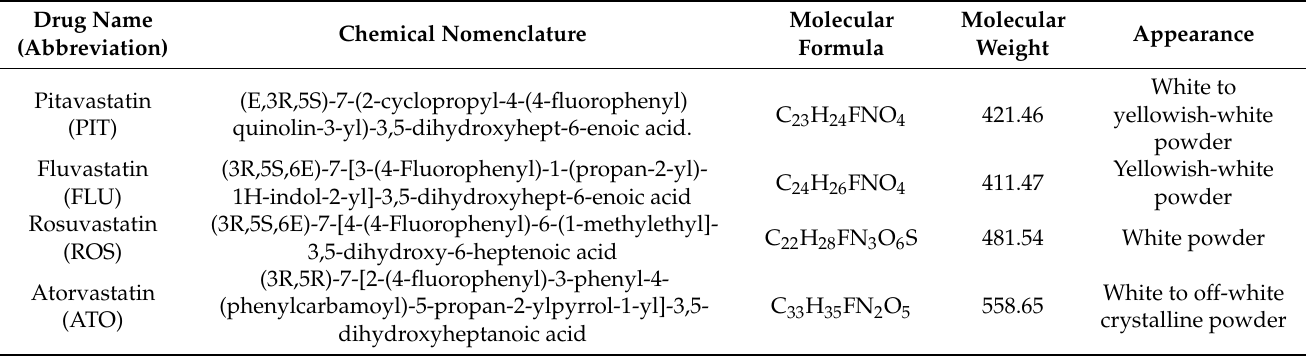
Table 1. The names, chemical nomenclatures, and physical properties of the investigated statins.